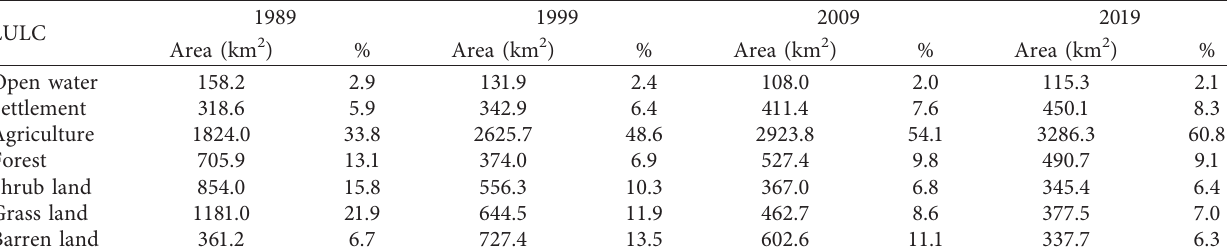
Figure 7: Land use coverage and magnitude of changes in km 2 and %. (a) Land use coverage in km 2 . (b) Land use coverage in %. (c) Land use changes in km 2 and land use changes in %. Table 8: Land use coverage in kilometres square (km 2 ) and percentage